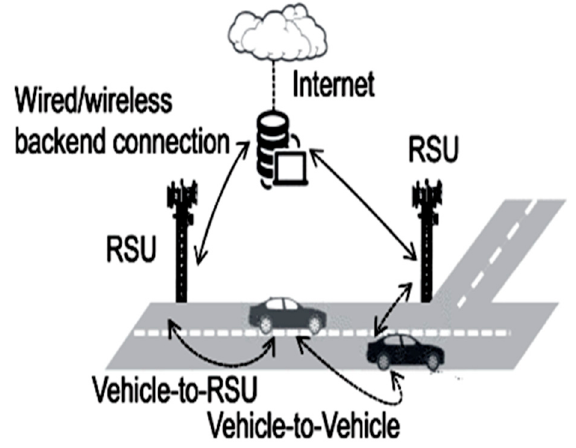
Figure 1. Vehicle to everything V2X technology [6].